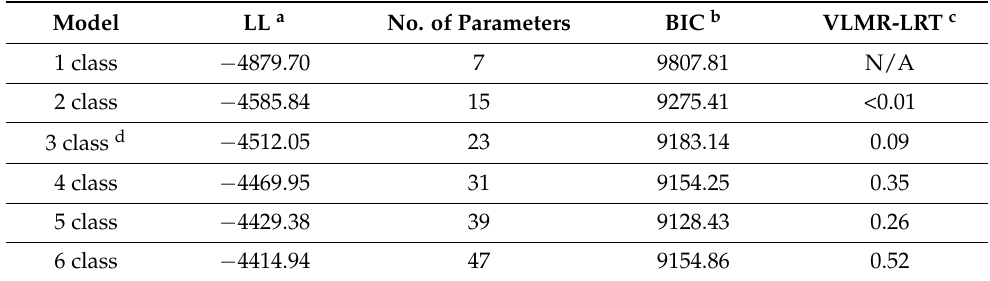
Table 2. Latent class analysis: model fit statistics to determine stigma beliefs and policy support classes: data from the nationally representative Amerispeak survey, February 2020 (n = 1007; results weighted to ensure national representativeness).